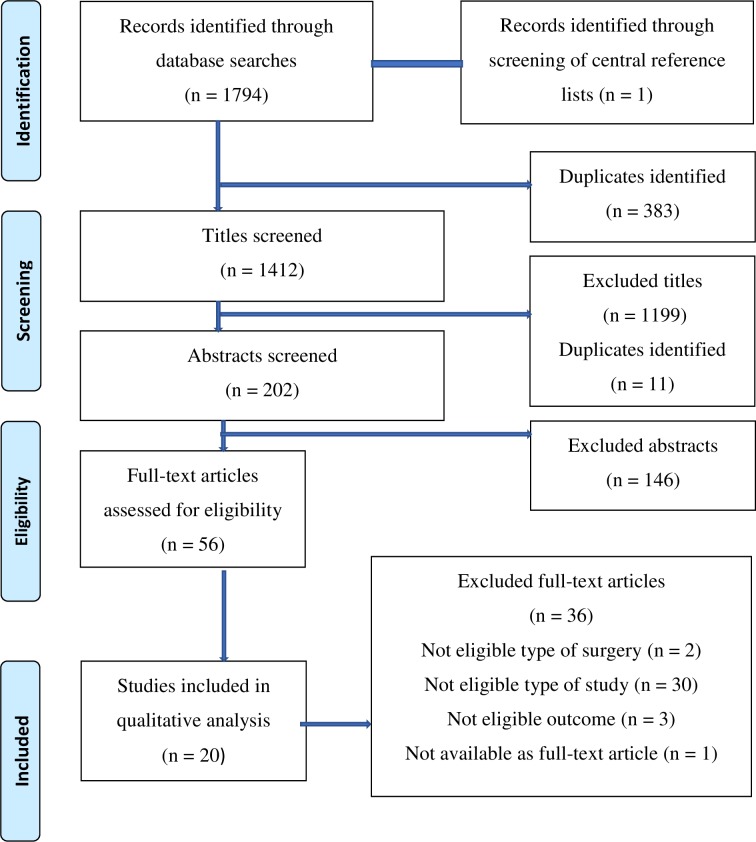
Flow diagram of study identification and selection.